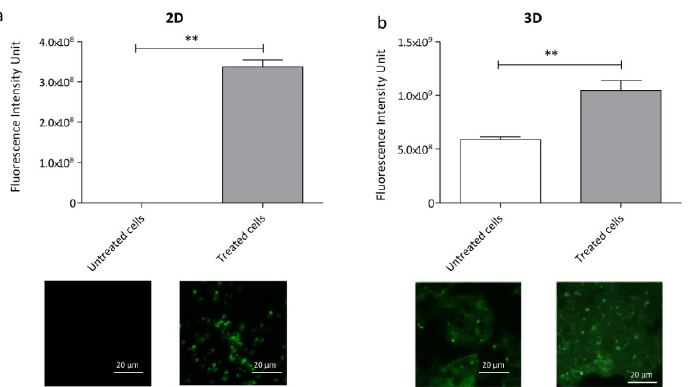
Figure 4. NSC34 differentiate in 14 days of culture. NSC34 were differentiated using DMEM High Glucose, 1% penicillin/streptomycin, 1% L-glutamine and 10 μM all-trans retinoic acid (RA), and the differentiation process was evaluated at days 0, 1, 4, 7, 11 and 14 using the optical microscope Axio Imager 2 (Zeiss, Oberkochen,Germany). Cells began to show propagation already at day 1 and then grouped into colonies with many interconnections. Scale bar = 25 μm.